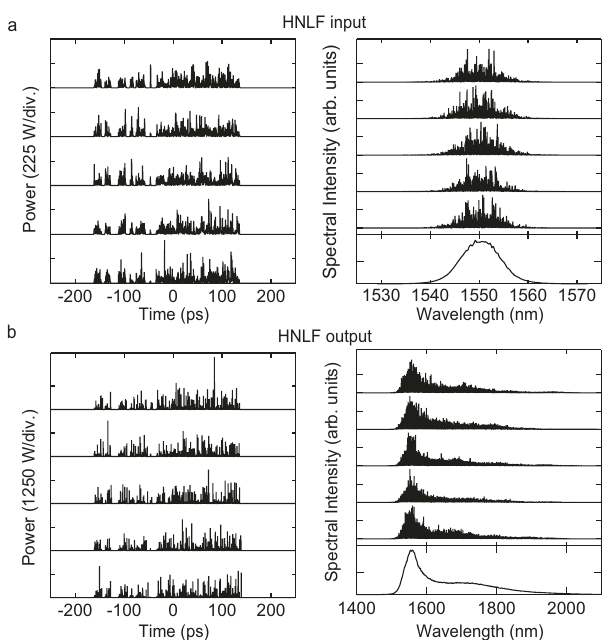
Fig. 4 Simulated temporal and spectral characteristics showing shot-to- shot fl uctuations. Results from numerical simulation plotting temporal and spectral characteristics over 5 roundtrips at a the HNLF input and b the HNLF output. For the spectral results, we also plot the mean spectrum computed over 1000 roundtrips (bottom sub fi gure). Because we plot results on a linear scale here to highlight the shot-to-shot fl uctuations, we do not include the wavelength range of the low amplitude dispersive wave